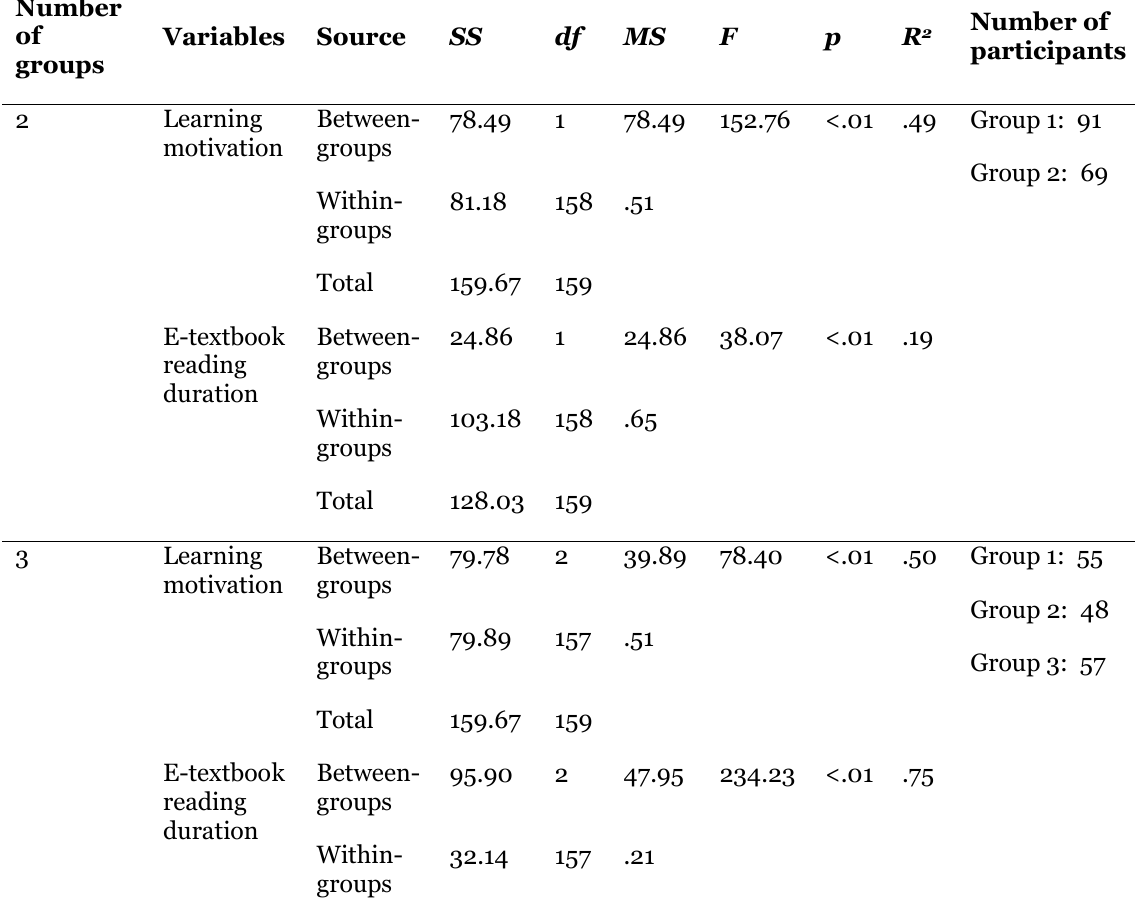
Cluster Analysis Results Using the Ward’s